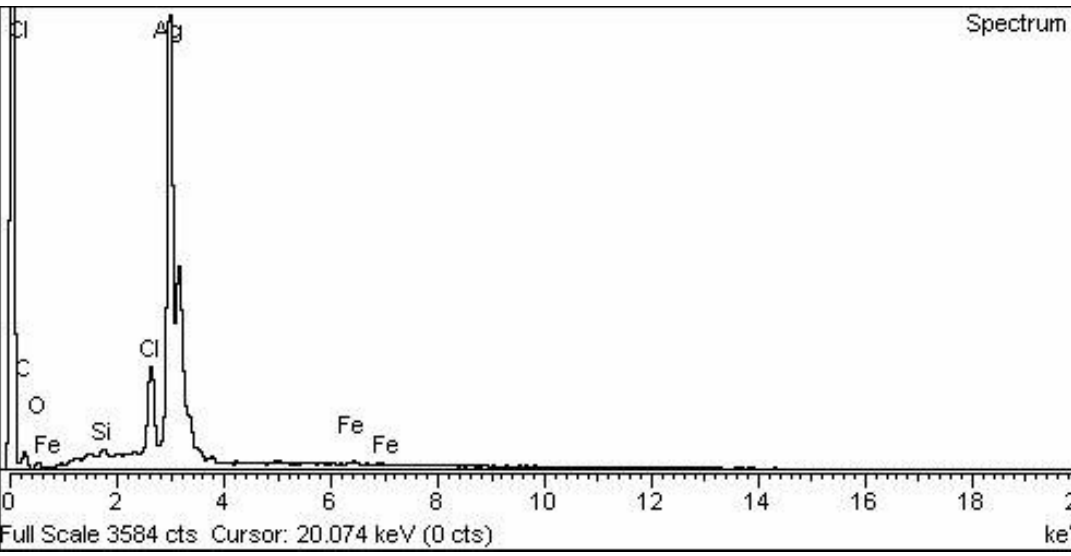
Figure 7. EDX spectra of the biosynthesized silver nanoparticles (AgNPs).